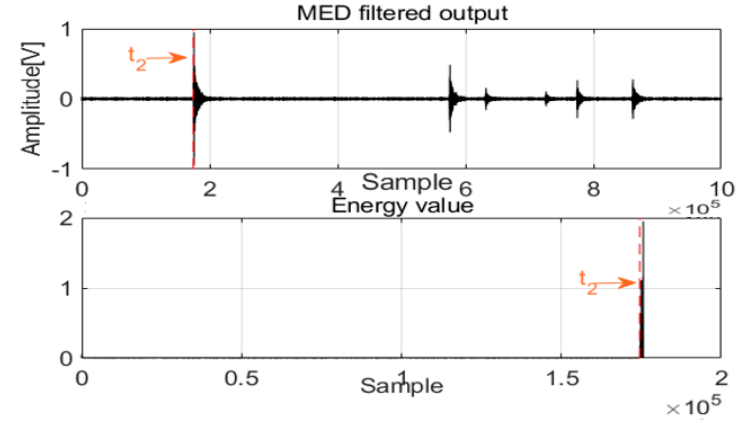
Figure 12. The first arrival time for Channel 2.